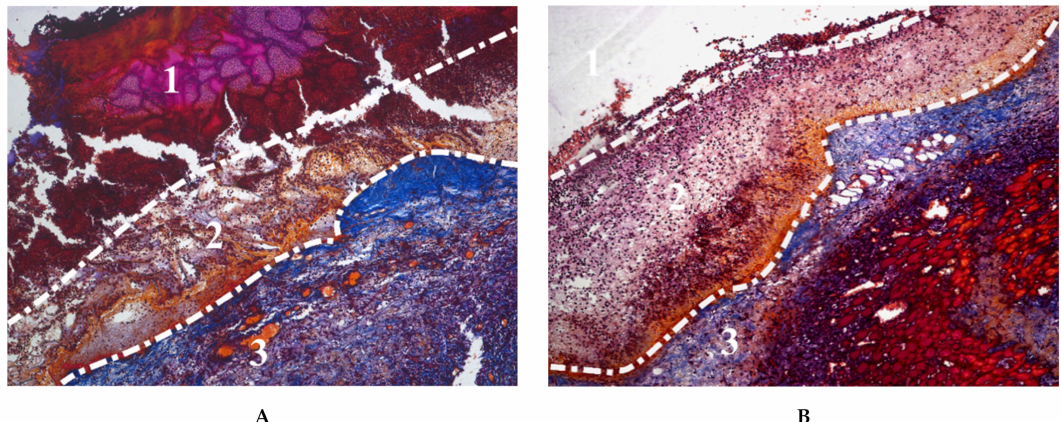
Figure 5. Microphotographs of Mallory-stained tissue sections from wounds treated with: ( A ) non-doped and ( B ) Zn-doped gelatin cryogel, at day 3 after trauma. (1) debris layer containing the cryogel surrounded by fibrous capsule, (2) initial granulation tissue, (3) mature granulation